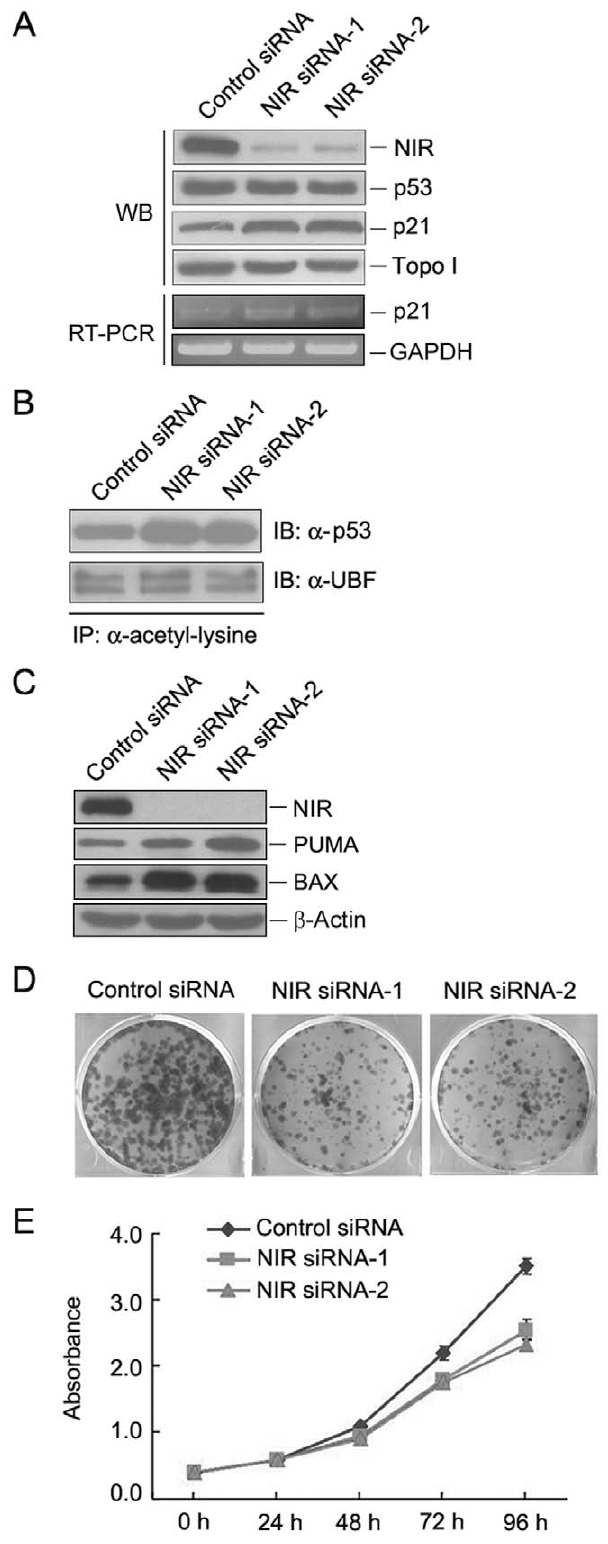
Figure 6. Depletion of NIR may activate p53 by de-repressing p53 acetylation. A. U2OS cells were transfected with NIR-specific siRNA or control siRNA respectively. At 72 hrs post transfection, cell lysates were prepared. Proteins from the lysates were separated on SDS-PAGE, transferred onto PVDF membrane. Blot was probed